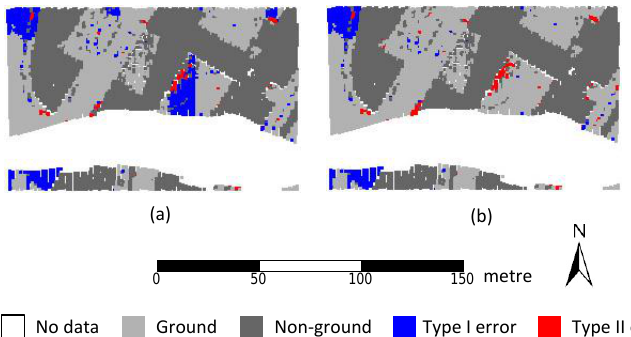
Figure 13. Results of the proposed method filtering sample 41: ( a ) filtering with elementary isotropic structuring element and directional structuring elements; and ( b ) filtering with elementary isotropic structuring element.